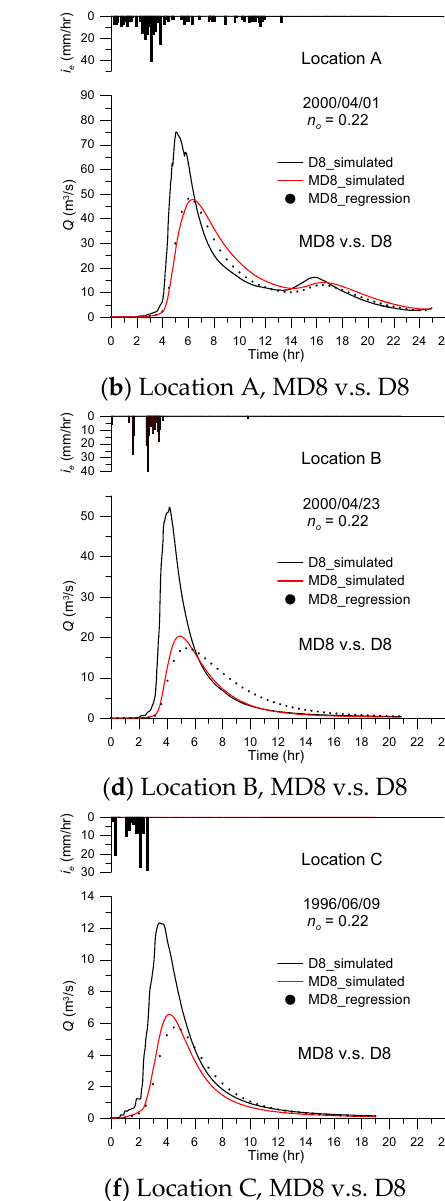
Table 3. Area indexes and estimated hydrography deviations ( DV and DT ) at the three locations in the Goodwin Creek Watershed.